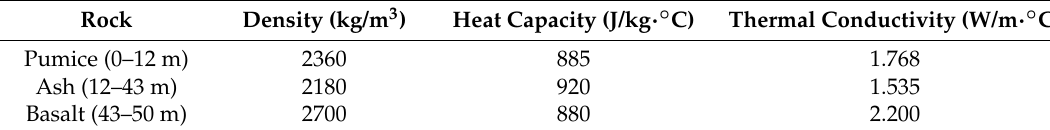
Table 1. Thermophysical properties of the drilled cores from W1 [29].